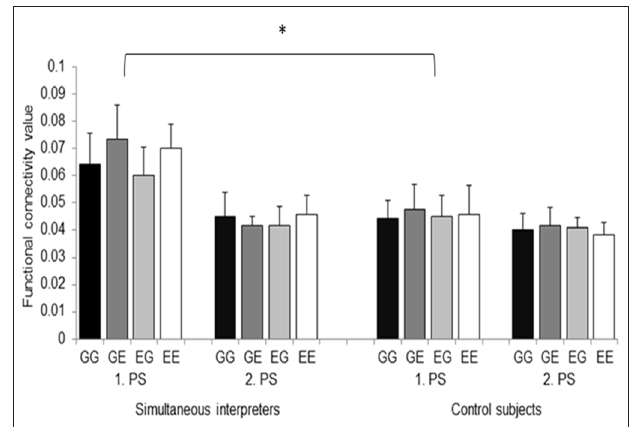
FIGURE 3 | Functional connectivity values between the left ARC and Broca’s region are depicted separately for the 2 groups, the 2 processing stages (i.e., 1. PS and 2. PS), and the 4 language directions. GG, German-German; GE, German-English; EG, English-German; EE, English-English. Error bars indicate standard error. ∗ p <